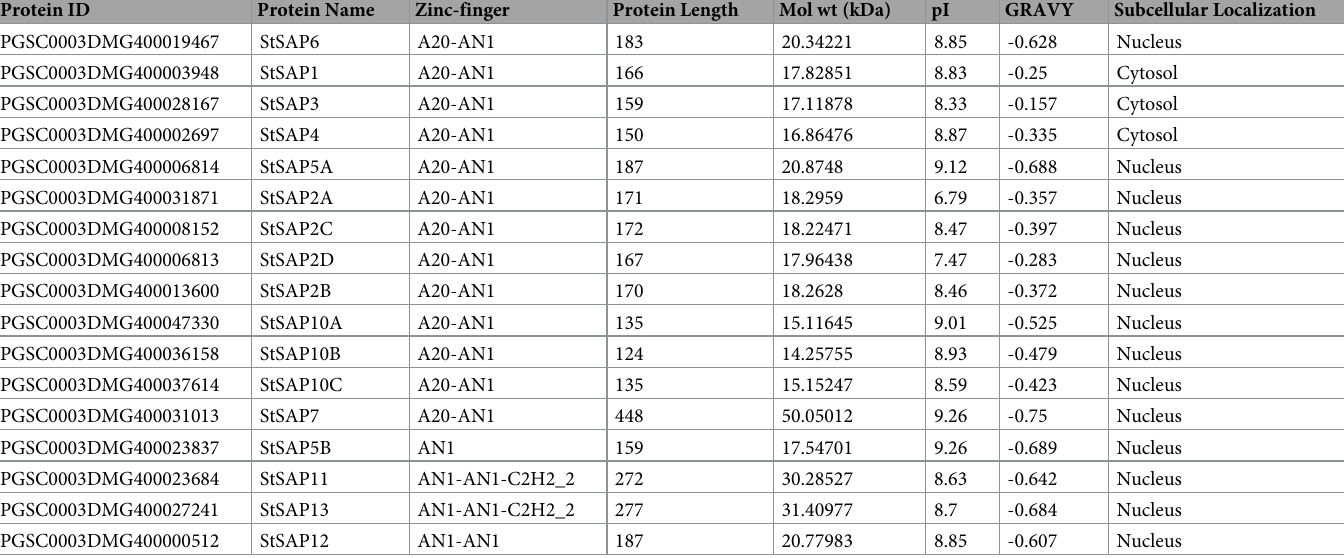
Table 2. Distribution of StSAP protein family containing A20/AN1 domains. Protein